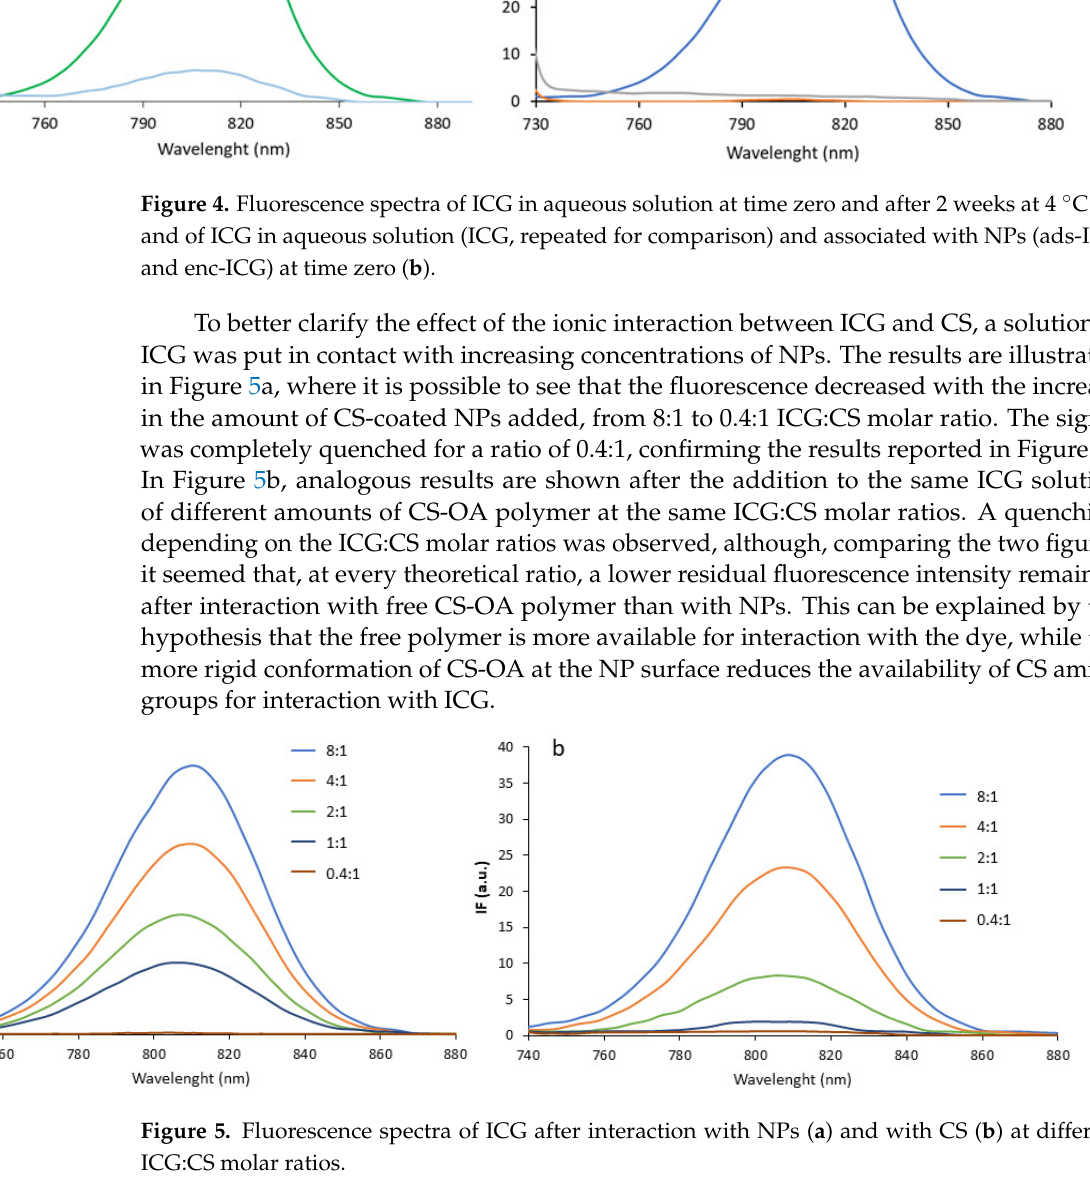
Figure 4. Fluorescence spectra of ICG in aqueous solution at time zero and after 2 weeks at 4 °C ( a ), and of ICG in aqueous solution (ICG, repeated for comparison) and associated with NPs (ads-ICG and enc-ICG) at time zero ( b ).